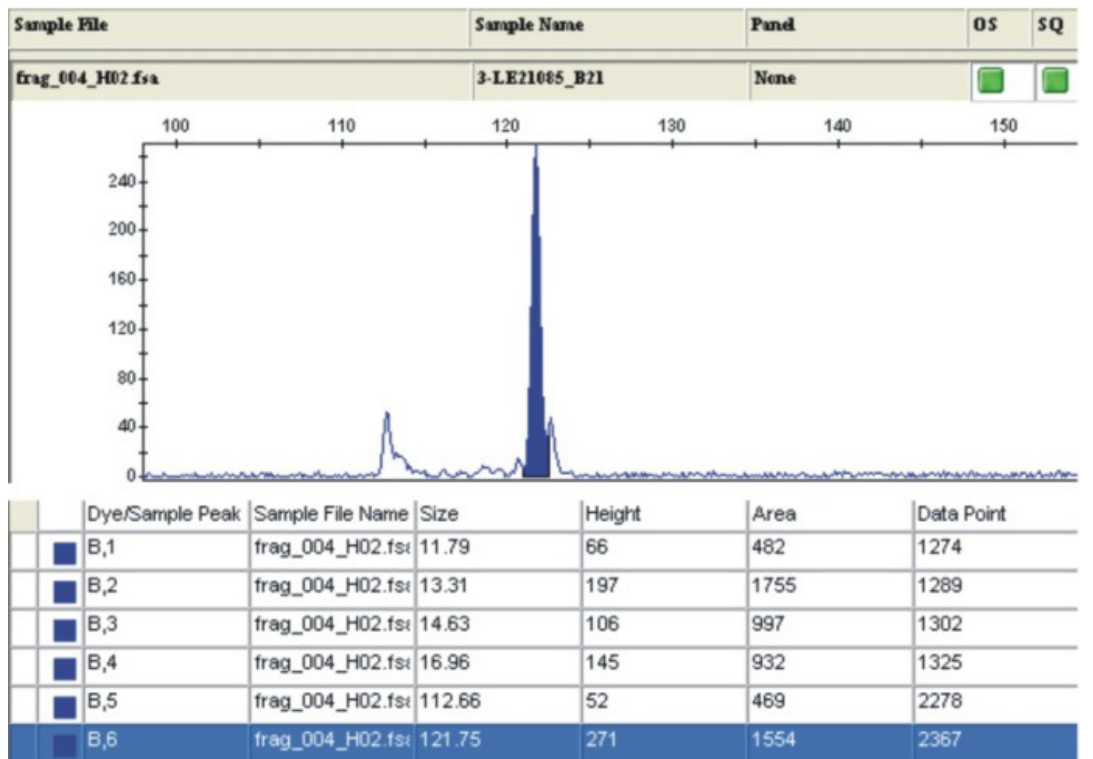
Fig. 2. The electropherograms of locus LE21085 in the researched tomato